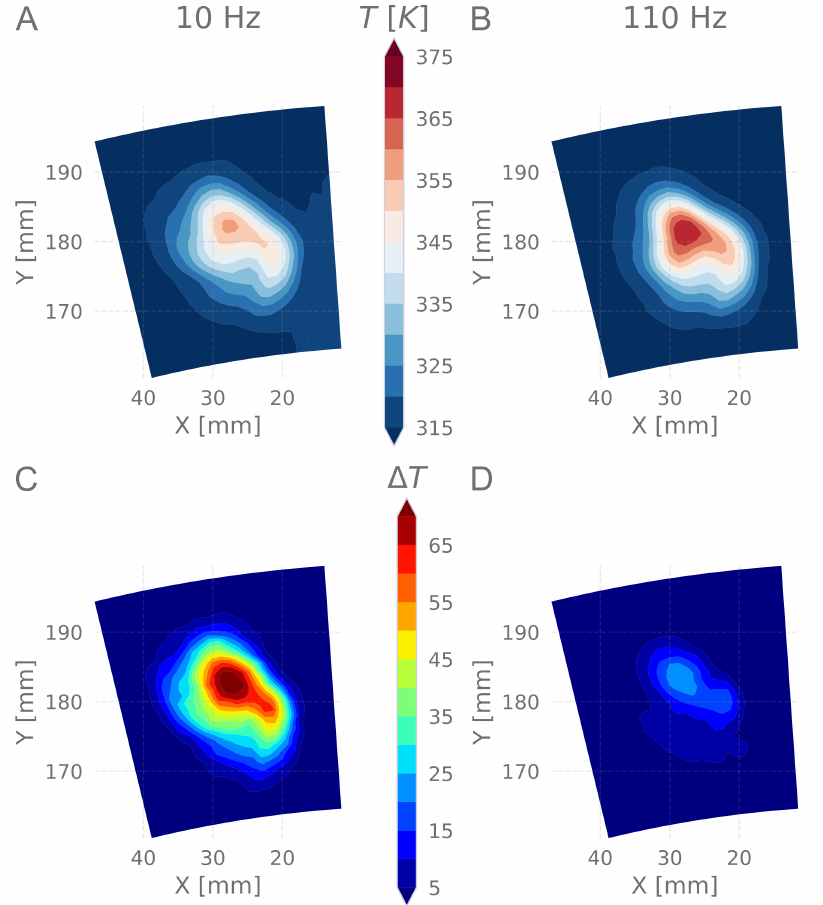
Figure 3. EWG generated disturbance assessment (Plane T1). Contour plots of: total temperature in frames ( A , B ); peak-to-trough temperature value in ( C , D ). ( A , C ) “10 Hz” case; ( B , D ) “110 Hz”